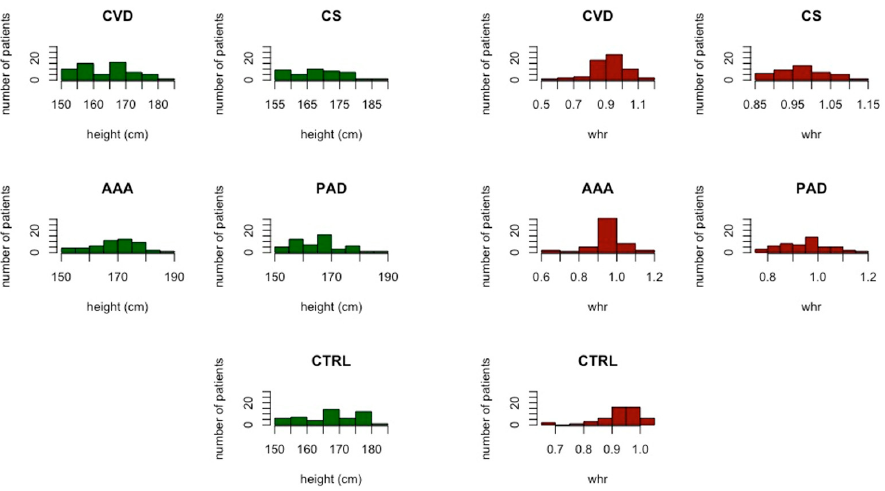
Figure 2. Distribution of Height and WHR in CVD, CS, AAA, and PAD. (WHR = waist-to-hip ratio)